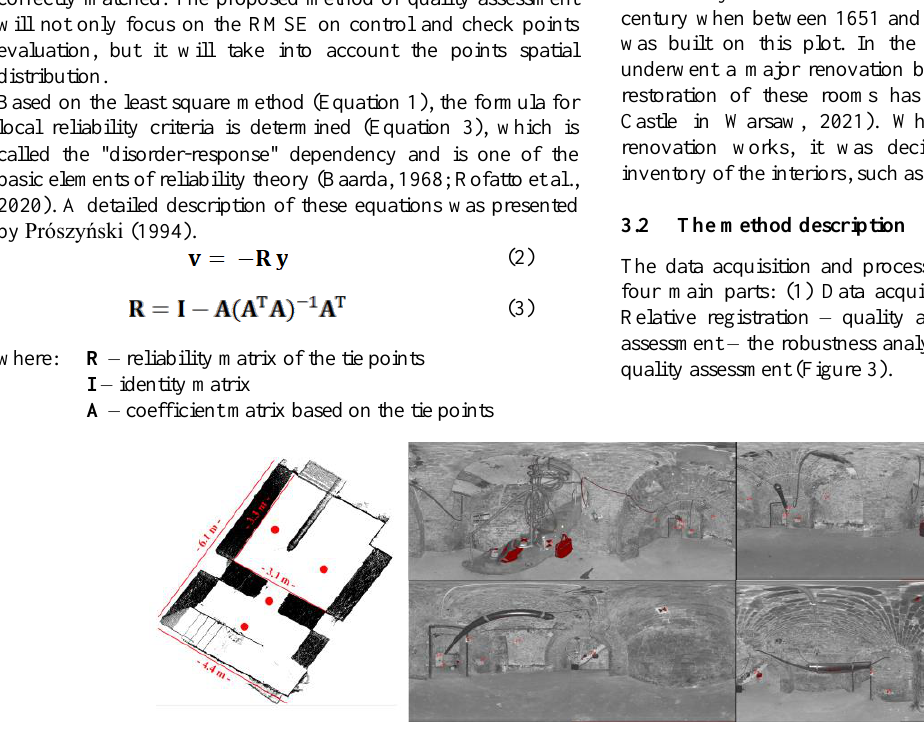
Figure 2. The floor plan with marked Terrestrial Laser Scanning (TLS) scanner positions and four TLS point clouds as spherical